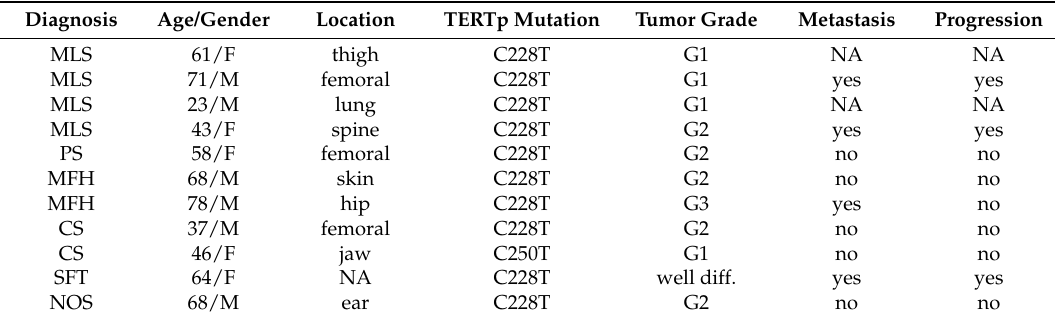
Table 3. Details of TERT promoter ( TERTp ) mutated-patients.